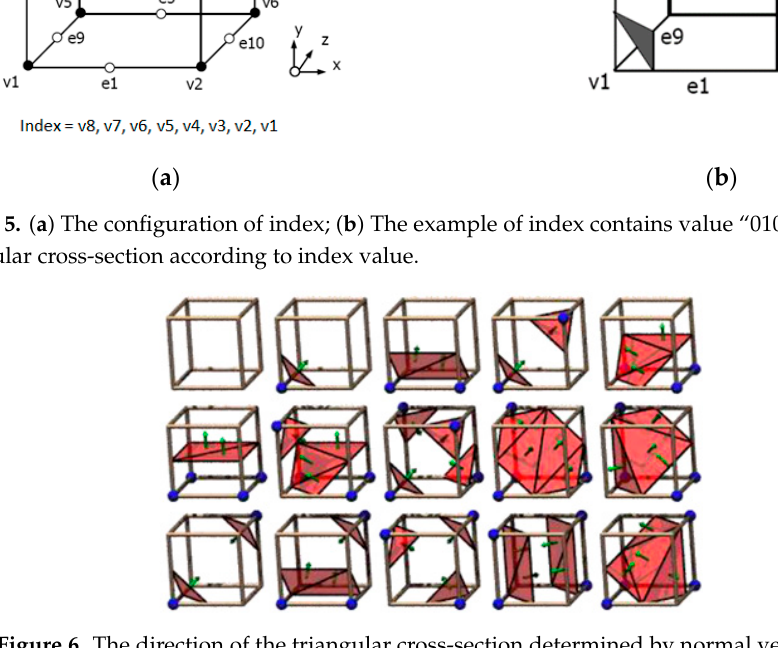
Figure 6. The direction of the triangular cross-section determined by normal vector [15].